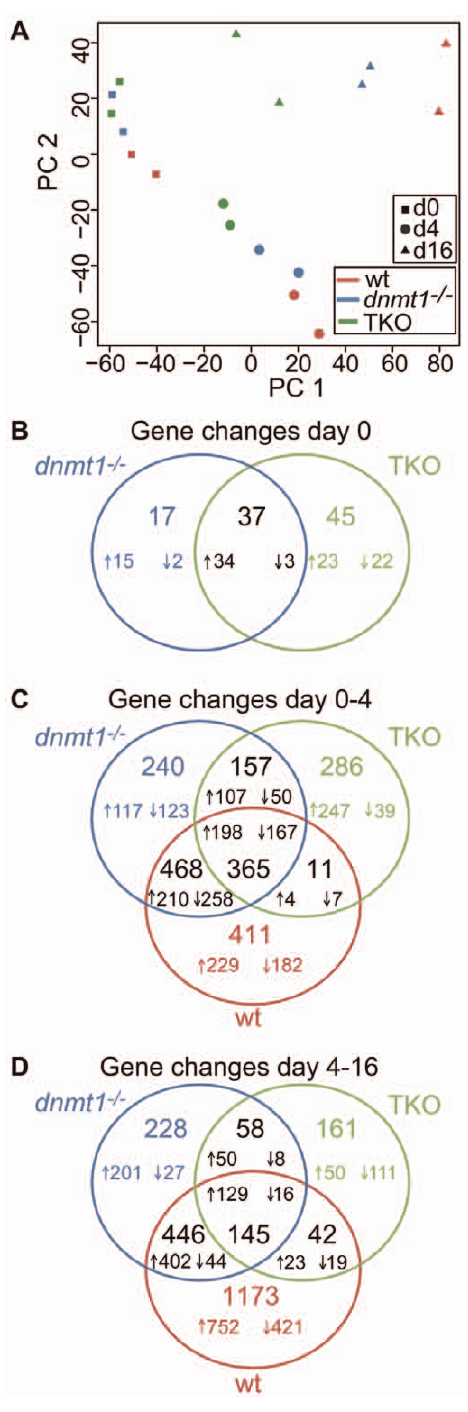
Figure 3. Genome-wide expression analysis of wt, Dnmt1 2 / 2 and TKO ESCs during differentiation as EBs. RNA samples from undifferentiated ESCs and respective EBs at day 4 and 16 of differentiation were subjected to microarray expression analysis. A) Two dimensional principal component analysis of independent biological duplicates per cell line per time point. B) Venn diagram of differentially expressed genes in Dnmt1 2 / 2 (blue circles) and TKO (green circles) ESCs with respect to wt ESCs. (C, D) Venn diagram of gene changes occurring between day 0–4 (C) and day 4–16 (D) in knockout and wt (red circles) EBs. Gene changes occurring during the two differentiation intervals in wt and mutant EBs were determined and compared. Larger numbers indicate total numbers of gene